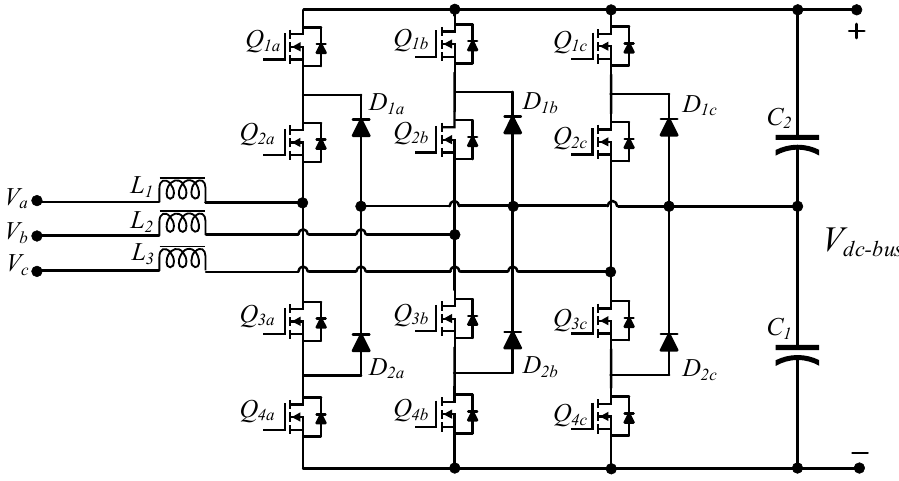
Figure 16. Three-level three-phase NPC converter.